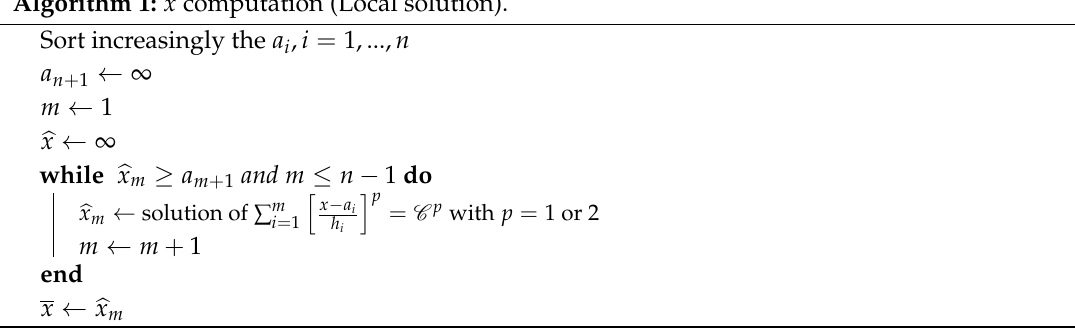
Algorithm 1: x computation (Local